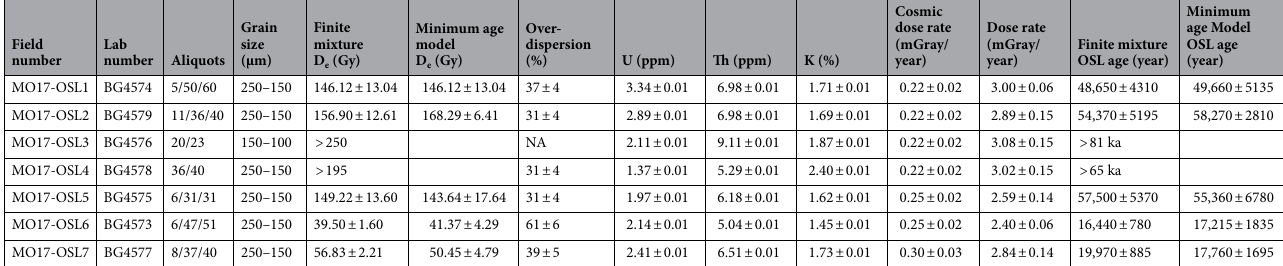
Table 1. Optically Stimulated Luminescence (OSL) ages on quartz grains sampled in the Mogod trenchsite. See Supplementary Data material for methodology, full description and